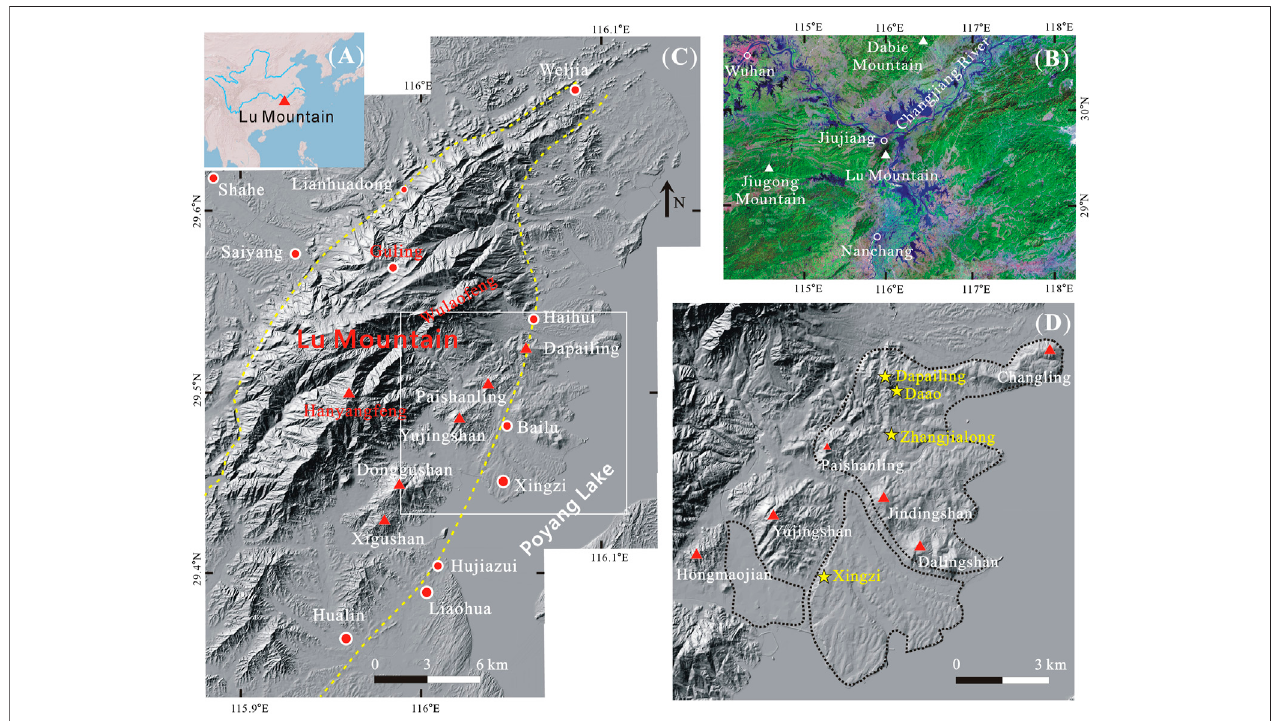
FIGURE 1 | Topography of the study area and study site. (A) Map of Eastern Asia. (B) Regional Thematic Mapper (TM) remote sensing image (data from http:// www.gscloud.cn). (C) Digitalelevationmodel(DEM)ofLuMountainwithaspatialresolutionof30 m.Dashedlinesrepresenttheboundaryfaults,andthewhiterectangle indicates the scope of panel D (D) Sampling sites (stars) on two fans located east of Lu Mountain. Dashed lines represent the approximate boundaries of the fans.